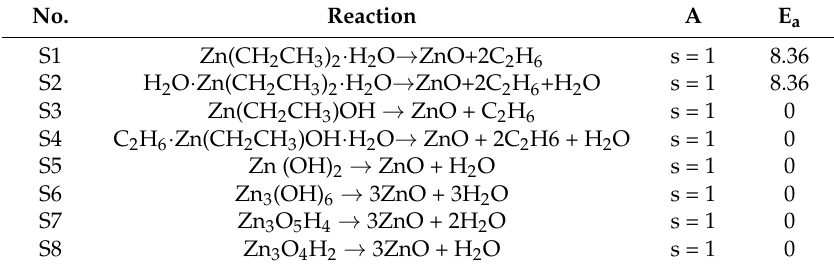
Table 2. Surface reaction pathways and kinetic parameters of for diethylzinc (DEZn) hydrolysis. No.